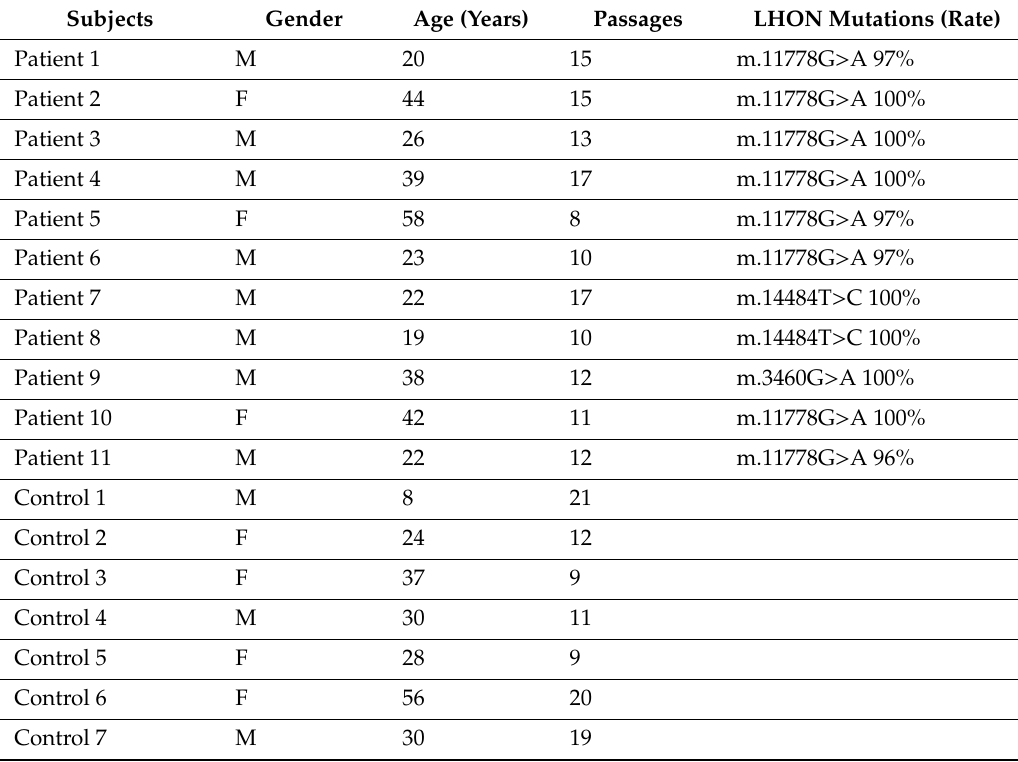
Table 1. Description of the cohort of patients and